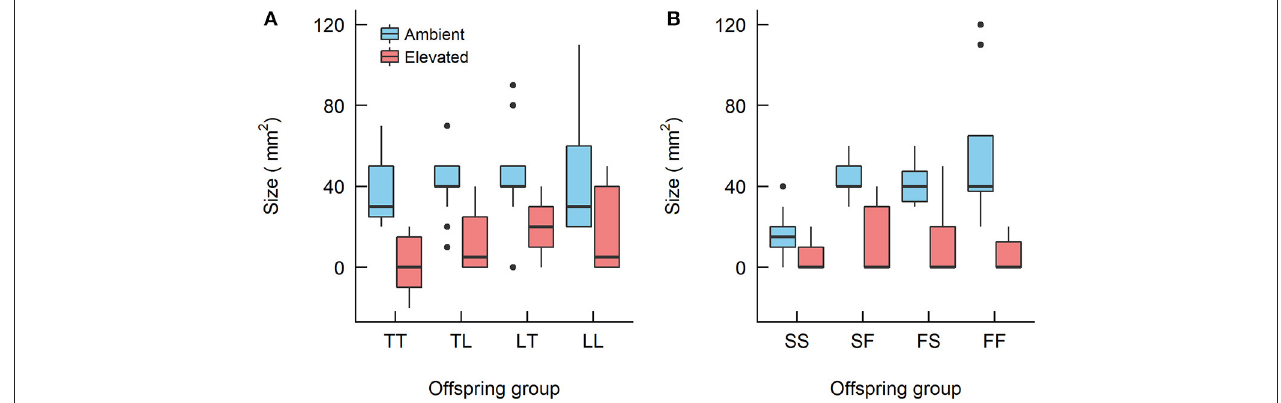
FIGURE 5 | Boxplots showing the size of the Acropora offspring groups at 28 weeks since treatment began from (A) the Acropora tenuis (T) × Acropora loripes (L) cross and (B) the Acropora sarmentosa (S) × Acropora florida (F) cross. The first letter of the offspring groups’ abbreviation represents the origin of the eggs and the second letter the origin of sperm. The horizontal bars represent median values, box length represents the interquartile range, and the small circles denote unusual points.